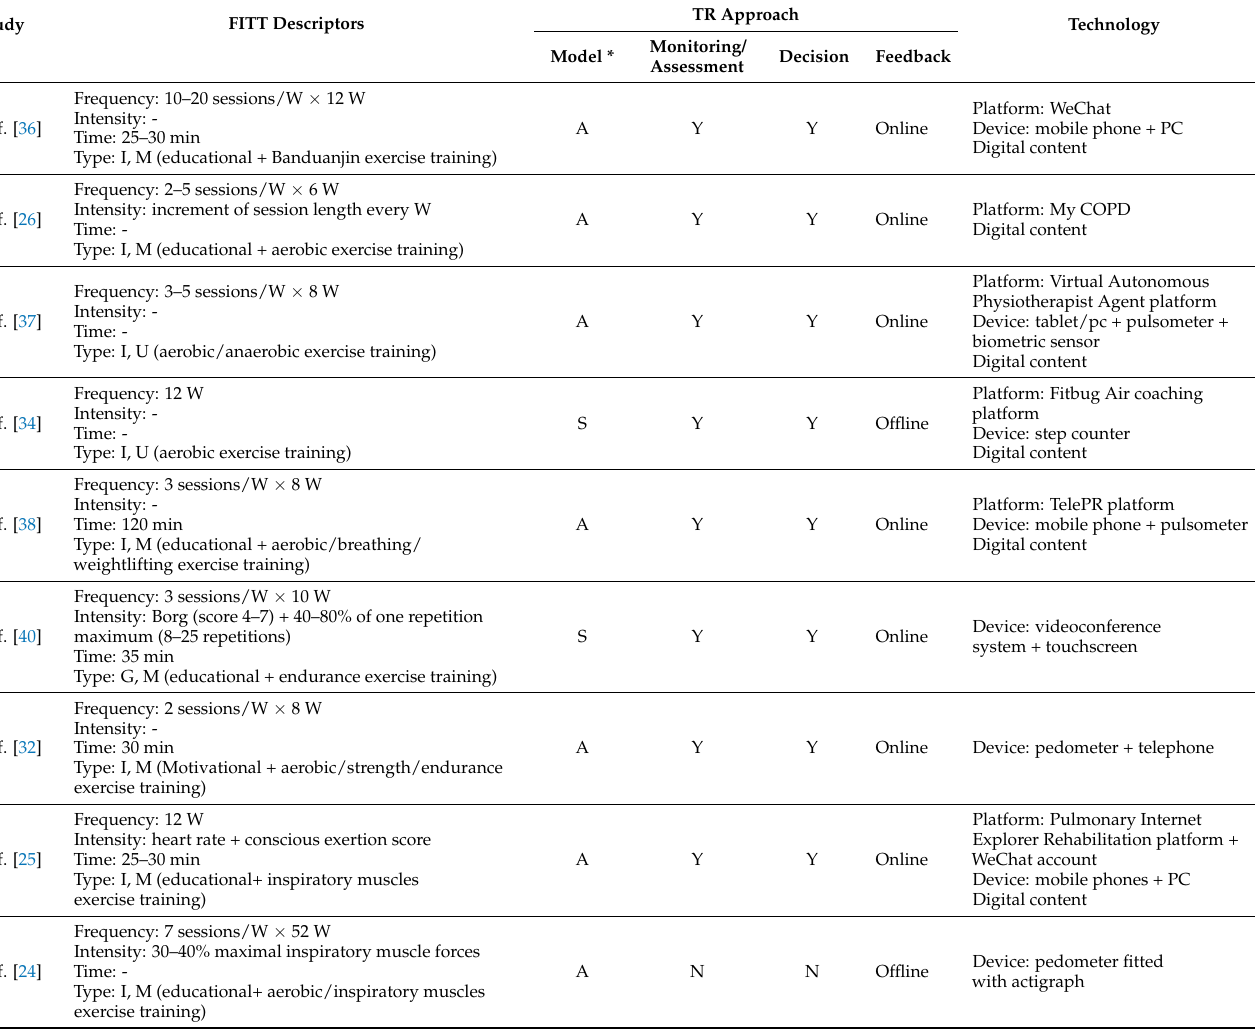
Table 3. TR Descriptors, approach, and technology.